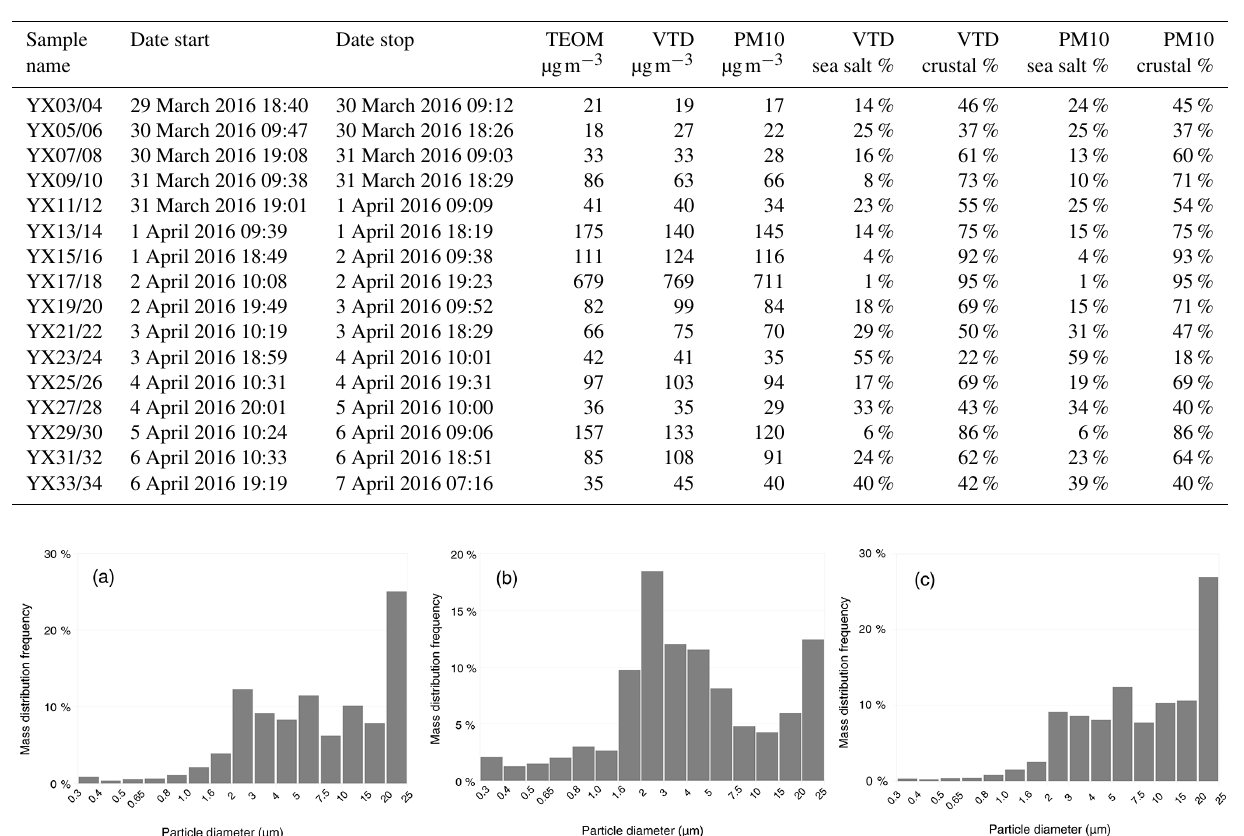
Table 1. Sampling dates (local time) and aerosol mass concentrations directly measured by TEOM and calculated from chemical analysis of samples collected by the VTD and PM10, respectively. Masses derived from chemical analyses are computed using equations presented in Sect. 2.6. The last four columns (right) display mass proportion of sea salt and crustal aerosol for VTD and PM10 samples. Detailed results are shown in Tables E1 and E2 (Appendix E).